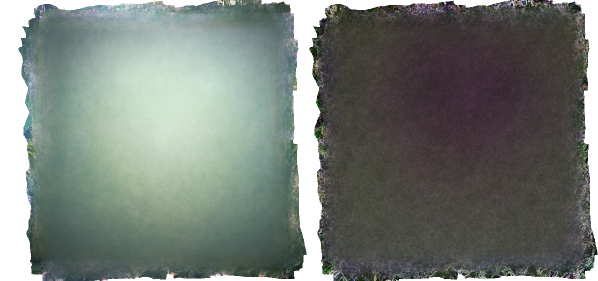
Figure 2. Mean value of the 143 images (left) and of their gradient modulus